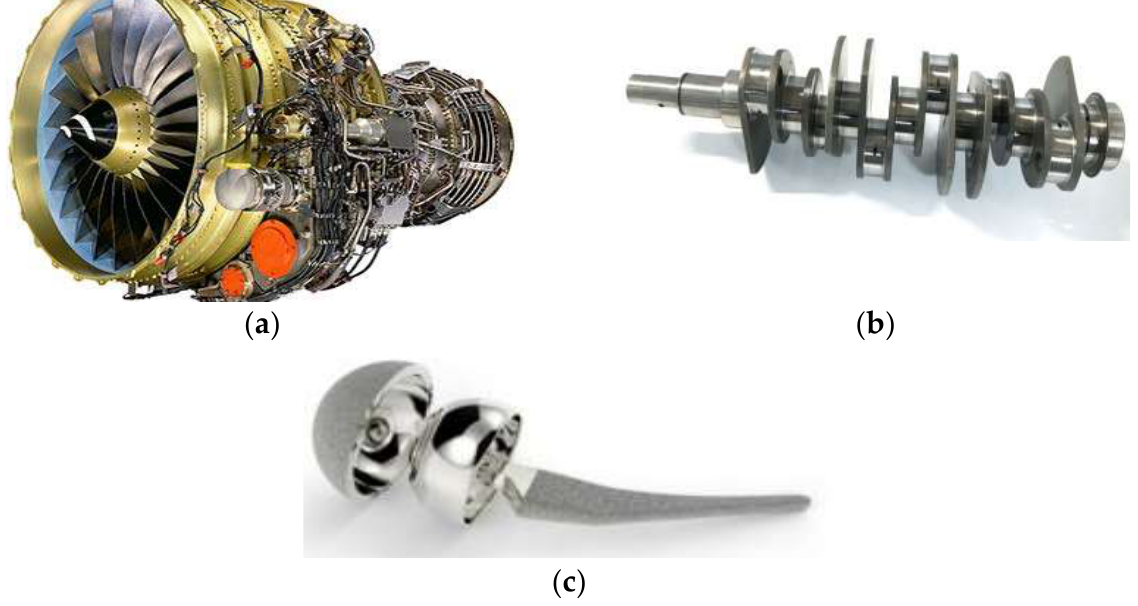
Figure 1. ( a ) Aircraft engine. ( b ) Titanium-MMC crankshaft ( c ) TMC cartilage implant [5–7].